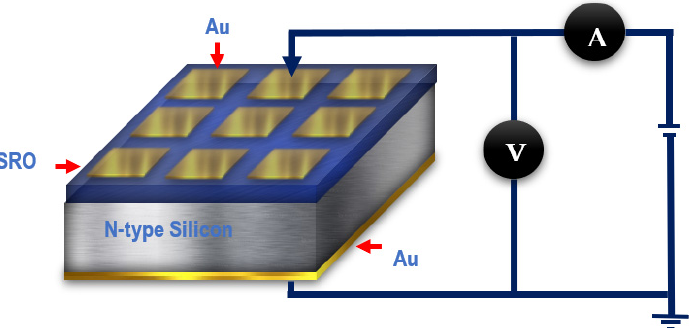
Figure 1. Device and circuit schematics for measuring I-V characteristics.